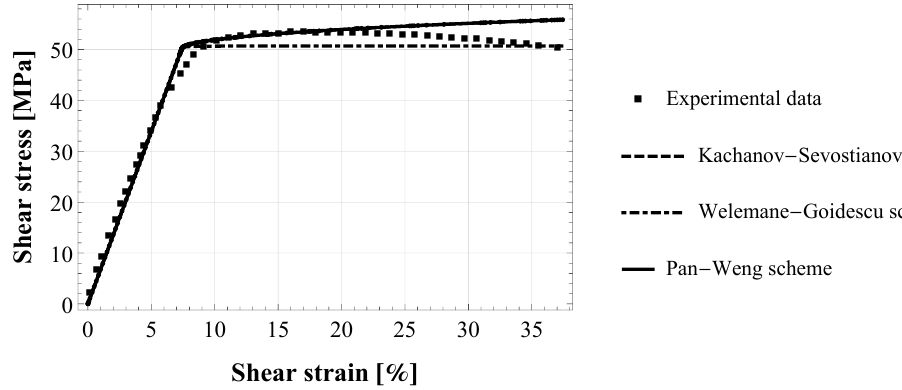
Figure 4. Torsional shear strain-stress ( γ − τ ) response of cylindrical butt-joint specimens of epoxy- based adhesive XA7416: fitting of the proposed numerical model (with Kachanov-Sevostianov, Welemane-Goidescu and Pan-Weng scheme) to the experimental data by